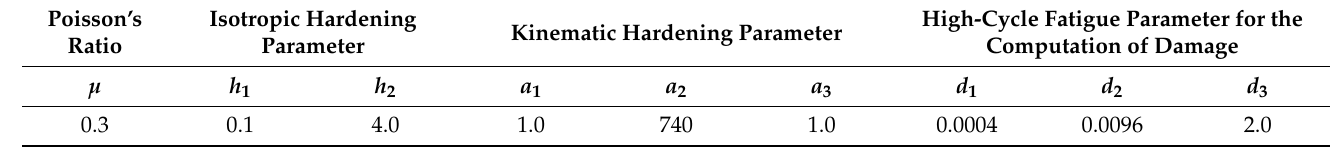
Table 4. Set of material constants obtained from the calibration of the numerical results against the experimental